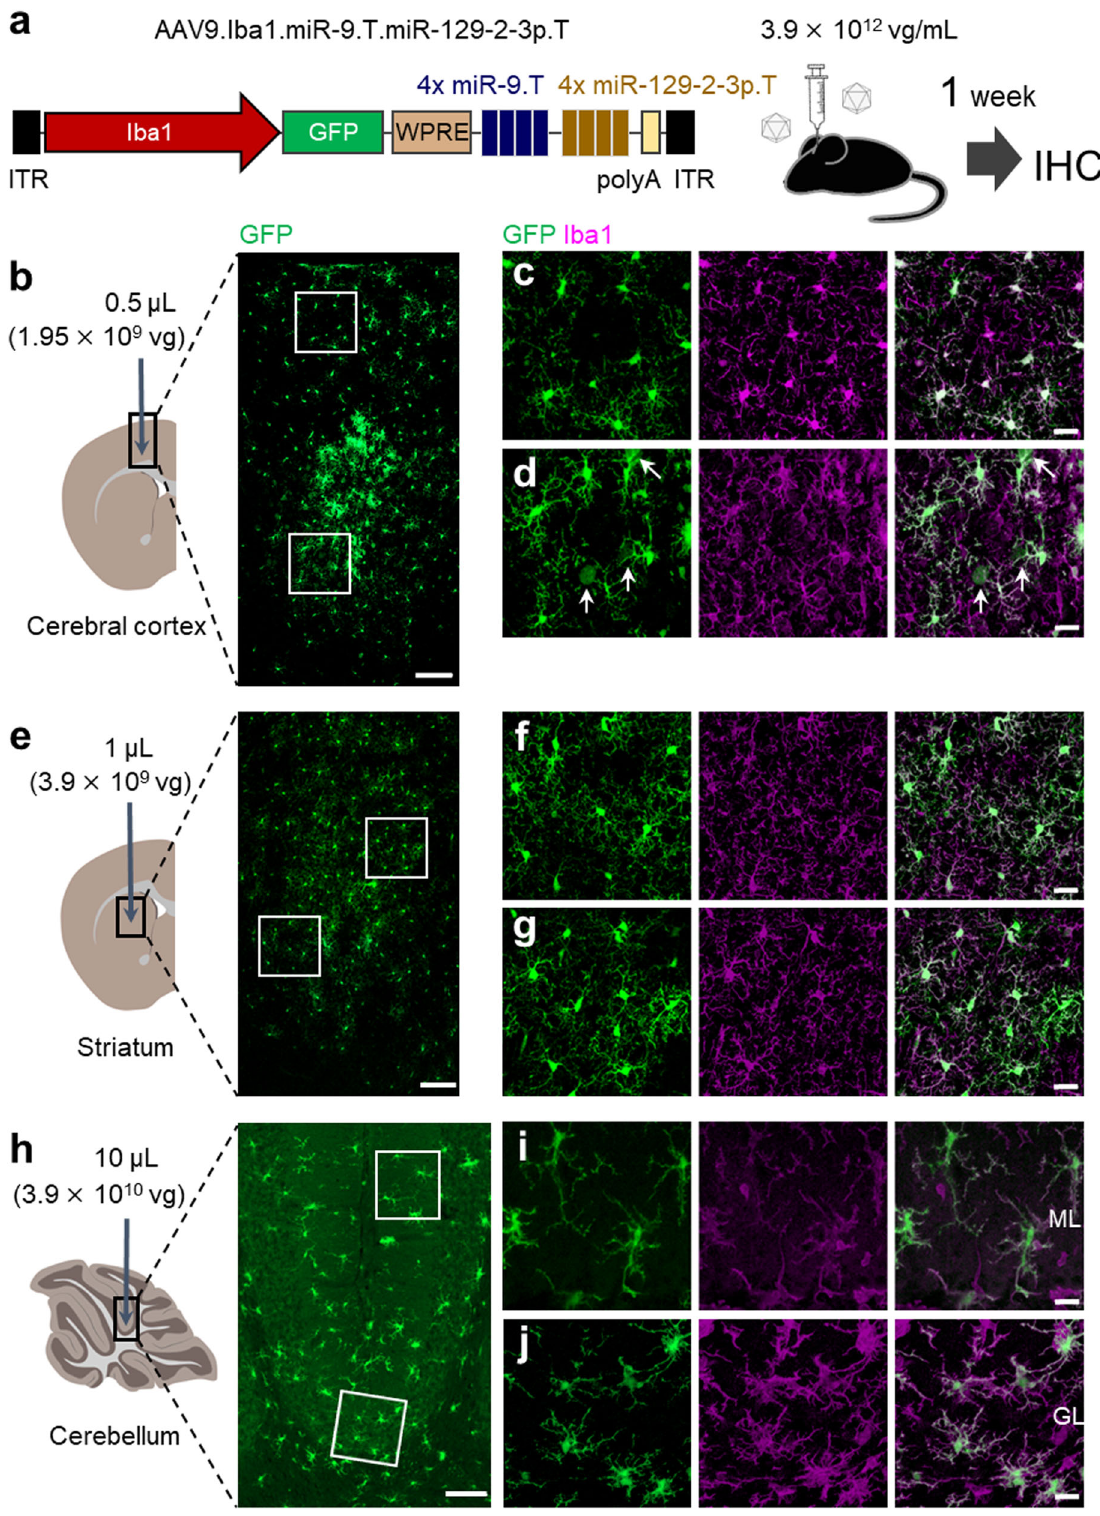
Fig. 2 Highly ef fi cient and speci fi c microglial targeting by AAV9.Iba1.miR-9.T.miR-129-2-3p.T. a Schema of the AAV construct comprising Iba1 promoter, GFP, and two different quadruplex sequences complementary to miR-9 and miR-129-2-3p. Mice received different doses of AAV (3.9×10 12 vg/mL) to the cerebral cortex (0.5 μ L), striatum (1 μ L) and cerebellum (10 μ L). One week after the viral injection, the mouse brains were examined by immunohistochemistry. ( b - d )Immunohistochemistry of the cerebral cortex. Square regions in b were enlarged. Note the strong and ef fi cient GFP expression in microglia with weak and rare transduction of Iba1-negative non-microglial cells (arrows). e – j Highly speci fi c transduction of microglia in the striatum ( e – g ) and cerebellum ( h – j ). Square regions in ( e , h ) were enlarged. Scale bars; 100 μ m ( b , e , h ) and 20 μ m ( c , d , f , g , i , j ). GL granule cell layer, ML molecular layer.